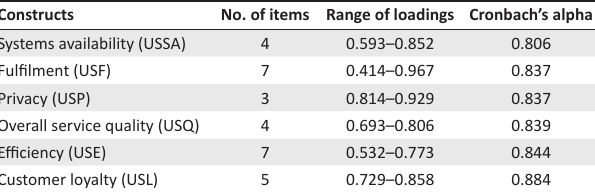
TABLE 2: Summary of reliability Unstructured Supplementary Service Data banking. Constructs